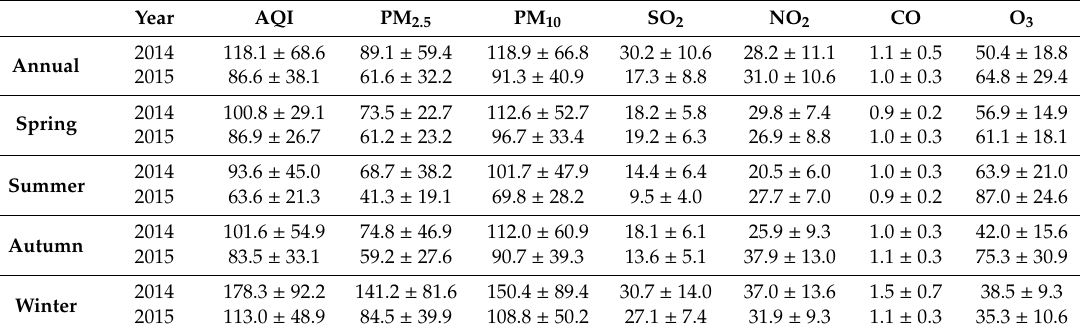
Table 1. Summary of air quality index (AQI) and the concentrations of six criteria air pollutants